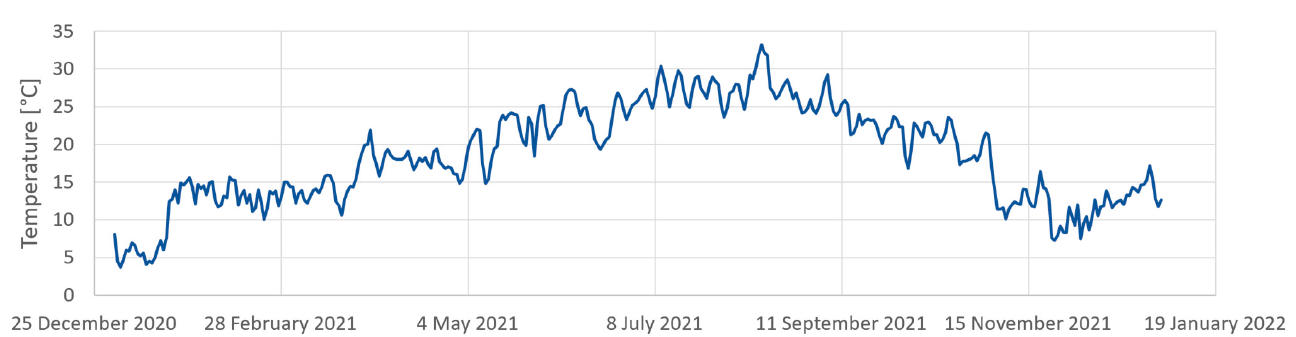
Figure 2. Daily temperatures in Seville during the year 2021 from the “La Rinconada” weather station.